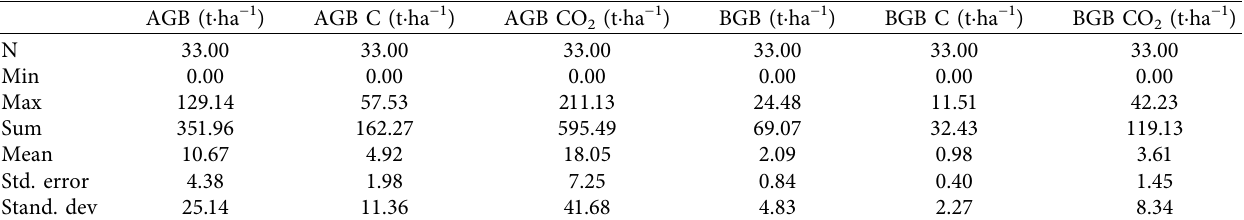
Table 3: Mean, maximum and minimum value of aboveground and belowground biomass, carbon stock, and carbon dioxide equivalent per tree spp. in Ziba forest.